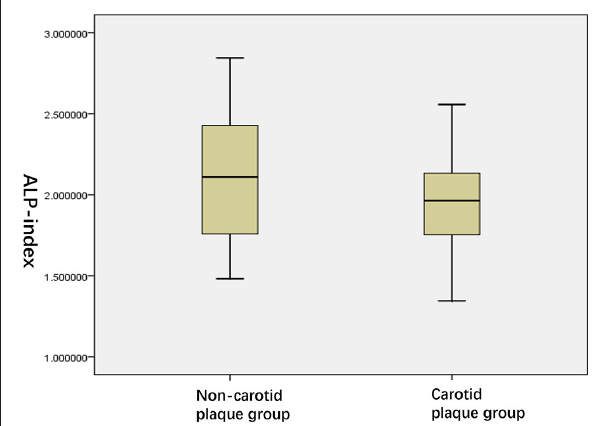
FIGURE 4 | ALPS-index in two